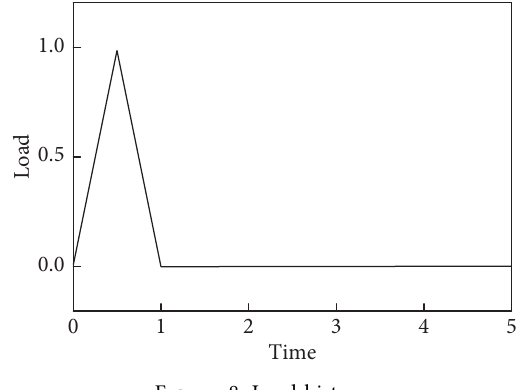
Figure 8: Load history.